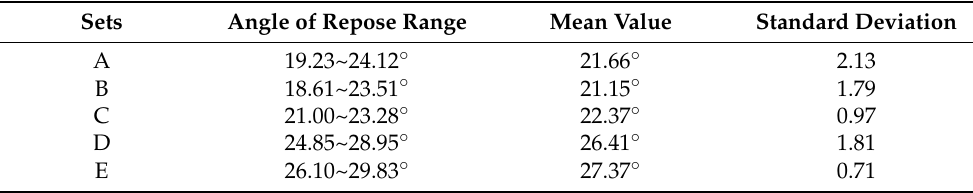
Table 3. Results of physical angle of repose test of sugarcane leaves with different shapes.